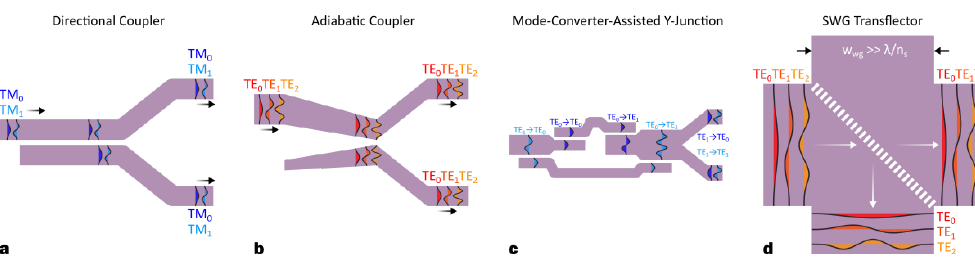
(right panel) are launched. The mode order cannot be preserved in the splitting process.